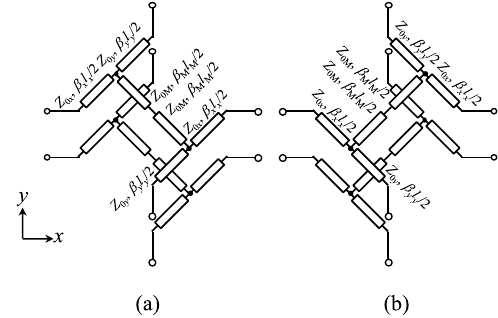
Fig. 3. Unit cells of the distributed full-tensor anisotropic medium. (a) m xy > 0. (b) m xy